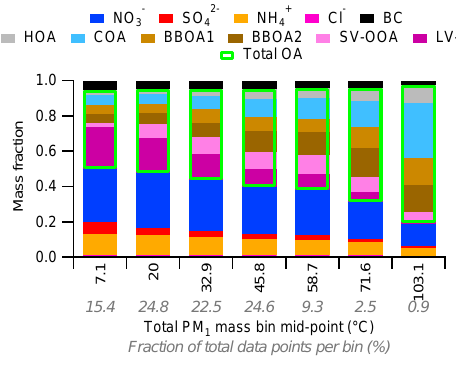
Figure 9. Mass fractional contribution to total PM 1 of the non- ) , sulfate refractory secondary inorganic species (nitrate (NO − 3 ) , ammonium (NH + ) , chloride (Cl − )) , black carbon (BC), (SO 2 − 4 4 and the six OA factors (hydrocarbon-like OA (HOA), cooking OA (COA), biomass burning OA 1 (BBOA1), biomass burning OA 2 (BBOA2), semivolatile oxygenated OA (SV-OOA), low-volatility oxygenated OA (LV-OOA)) as a function of total PM 1 mass during the whole campaign. The green outline indicates the fraction of to- tal OA. Note that the final bin comprises the top four mass bins in order to improve the statistics for these high loading bins. Figure 10. Comparison of aerosol composition between 2010 and 2013: (a) mass concentrations of all PM 1 species for the full mea- surement period and (b) fractional contributions of PM 1 species to the total PM 1 mass for the full measurement period. (c) and (d) are the same as (a) and (b) except that the fog events and precipita- tion events are removed from the 2010 data set and the cold pe- riod and precipitation events are removed from the 2013 data set. In all cases, the organic fraction has been separated into its respective components determined from PMF analysis. BBOA1 and BBOA2 from 2013 have been summed to give the total BBOA mass and fractional contributions. BC in 2010 was estimated using the ratio of BC to POA in 2013. The contribution of chloride to total mass is 1% in all